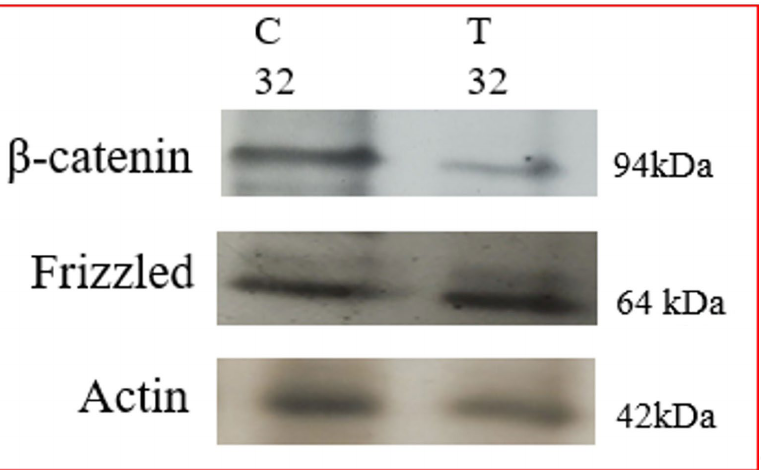
Figure 5. Western blotting of Wnt proteins: The capillary endothelial cells were cultured for 24 h and synchronized for 72 h. The cells were treated with or without Tunicamycin (1 µg/mL) for 32 h. At the end, the proteins were separated on 10% SDS-PAGE and transferred to nitrocellulose membranes. The blots were treated with anti-β-catenin and anti-frizzled monospecific antibodies followed by HRP-conjugated secondary antibodies and developed with EC reagents.